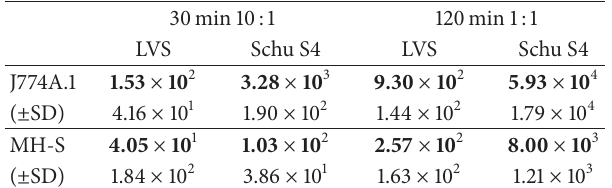
Table 1: Comparison of F . tularensis colonisation of cell lines at 30 minutes of exposure at an MOI of 10: 1 and 120 minutes at MOI of 1: 1, measured in cfu/mL. Under either condition in either cell line Schu S4 infected in significantly higher numbers ( 𝑃 < 0.005 by Student’s t -test). Values are the means from at least three independent